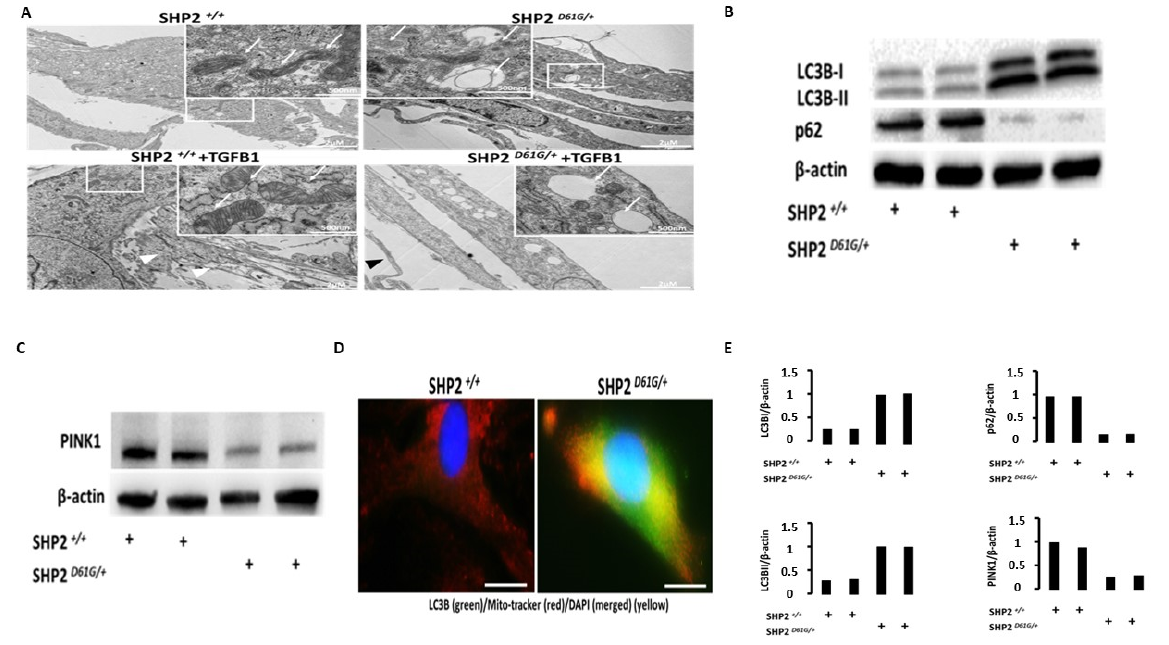
Figure 2. SHP2 D61G/+ constitutively active mutant MLFs display increased expression of autophagy markers, swollen mitochondria with disrupted cristae, and an increased number of autophagosomes. ( A ) Transmission electron microscopy (TEM) of SHP2 D61G/+ showed that SHP2 constitutive activation was associated with an increased number of autophagosomes and swollen mitochondria with disrupted, electro-lucent cristae (white arrows-insets). ( B ) Immunoblot analyses of autophagy markers (LC3BI/II) and autophagy receptors (p62) showed a LC3B high p62 low immunoblot pattern in SHP2 D61G/+ constitutively active mutant MLFs compared to wild-type ones (SHP2 +/+ ), indicating increased autophagy. ( C ) Double immunofluorescence analysis in MLFs validated immunoblot results showing co-localization (yellow-merged) of autophagy marker LC3B (green) with MitoTracker (red stain of active mitochondria) in SHP2 D61G/+ constitutively active mutant MLFs. ( D ) Immunoblot analysis of PINK1 (mediator of effective autophagy) showed decreased expression in SHP2 D61G/+ constitutively active mutant MLFs compared to wild-type ones (SHP2 +/+ ), potentially indicating ineffective autophagy. ( E ) Immunoblot densitometry analysis of LC3BI/II, p62, and PINK1 normalized to β -actin. Data are presented as bar graphs. Each bar represents an individual lane. Details for this figure are presented in Supplemental Data S2.